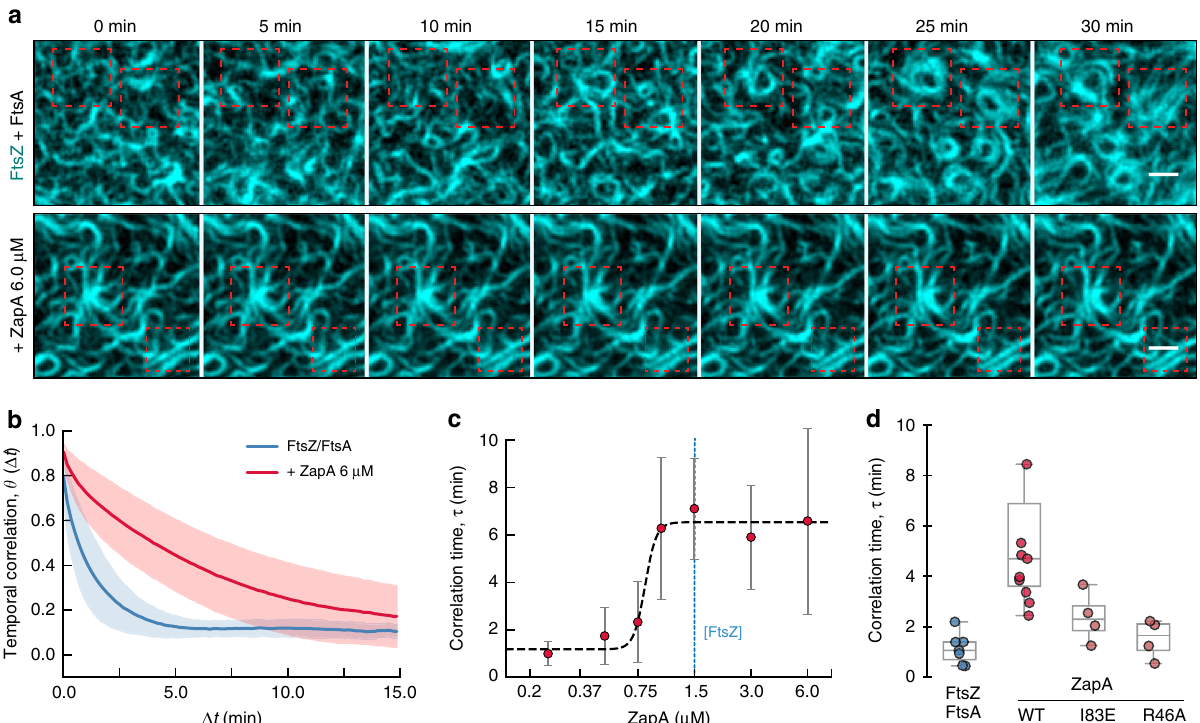
Fig. 3 ZapA stabilizes FtsZ fi lament bundles. a In the absence of ZapA (upper panel), the FtsZ fi lament pattern constantly reorganized and ring-like structures formed only transiently (red dashed squares). In contrast, in the presence of ZapA (lower panel) FtsZ assemblies were much more persistent. Scale bars, 2 μ m. b The temporal autocorrelation function of the FtsZ fi lament network decayed quickly without ZapA (blue), but slowly in the presence of 6.0 μ M (red). Each curve represents the mean ± std (error bands) of independent experiments (FtsZ, n = 7, ZapA, n = 9). c The characteristic correlation time, τ , as a function of ZapA concentration. The autocorrelation curves were fi tted to a mono-exponential decay and τ was given by the half-time of each decay. Once again, ZapA induced a switch-like behavior showing a hill coef fi cient » 4 and a EC50 = 1.05 (Supplementary Table 2). Data shown corresponds do the average τ from individual experiments (mean ± std). d ZapA I83E and R46A (light red) did not change the persistence of FtsZ fi lament bundles ( p > 0.05, Supplementary Table 1). Source data available at Figshare [https://doi.org/10.6084/m9. fi